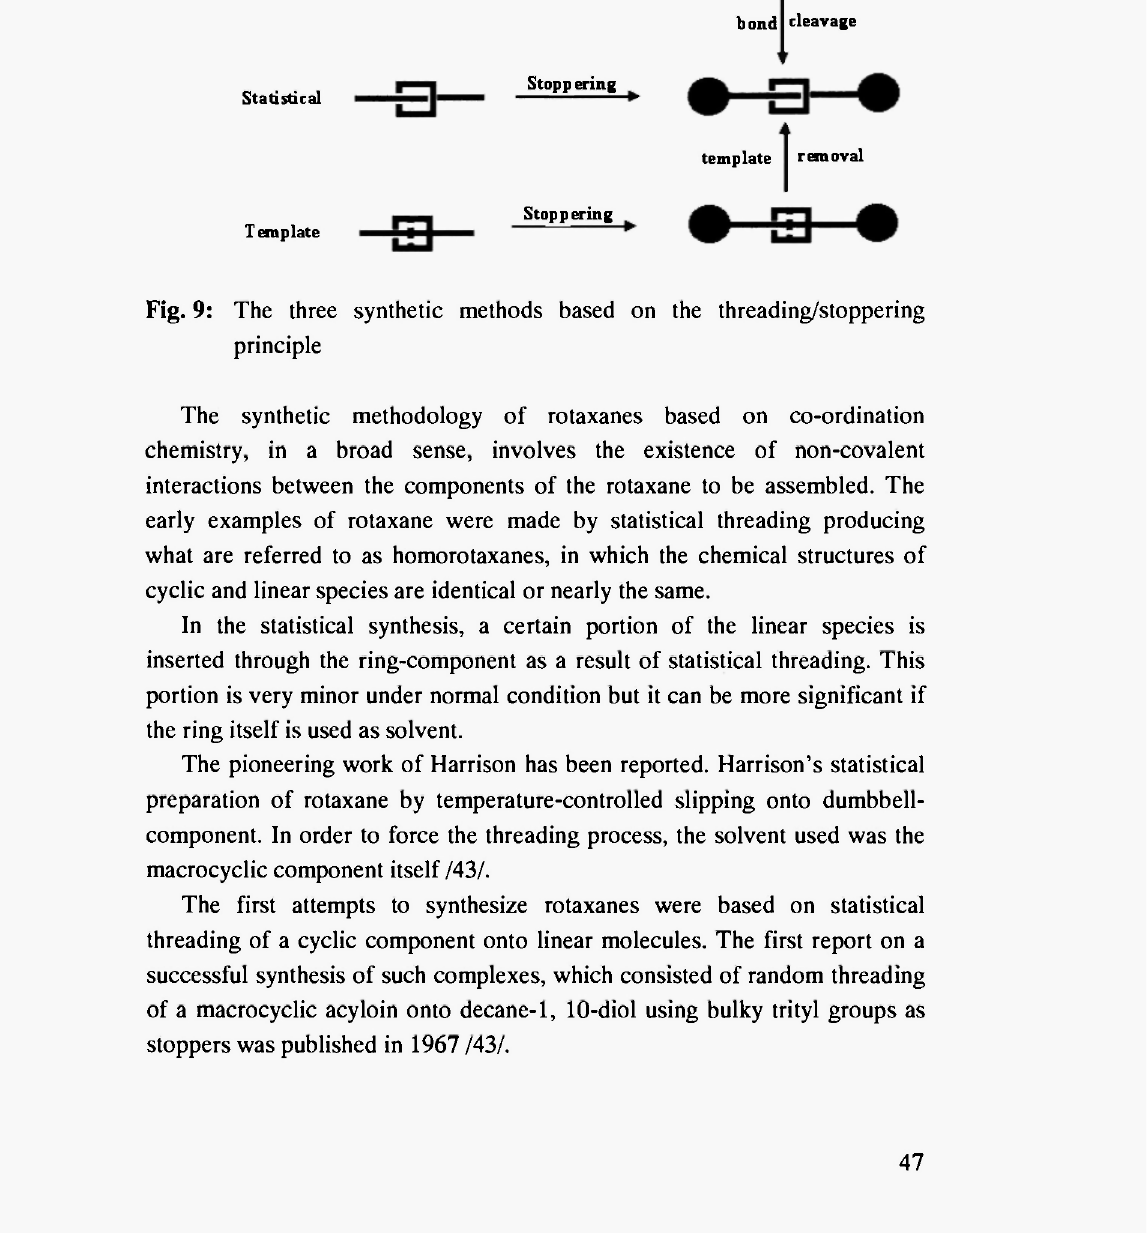
Fig. 9: The three synthetic methods based on the threading/stoppering principle The synthetic methodology of rotaxanes based on